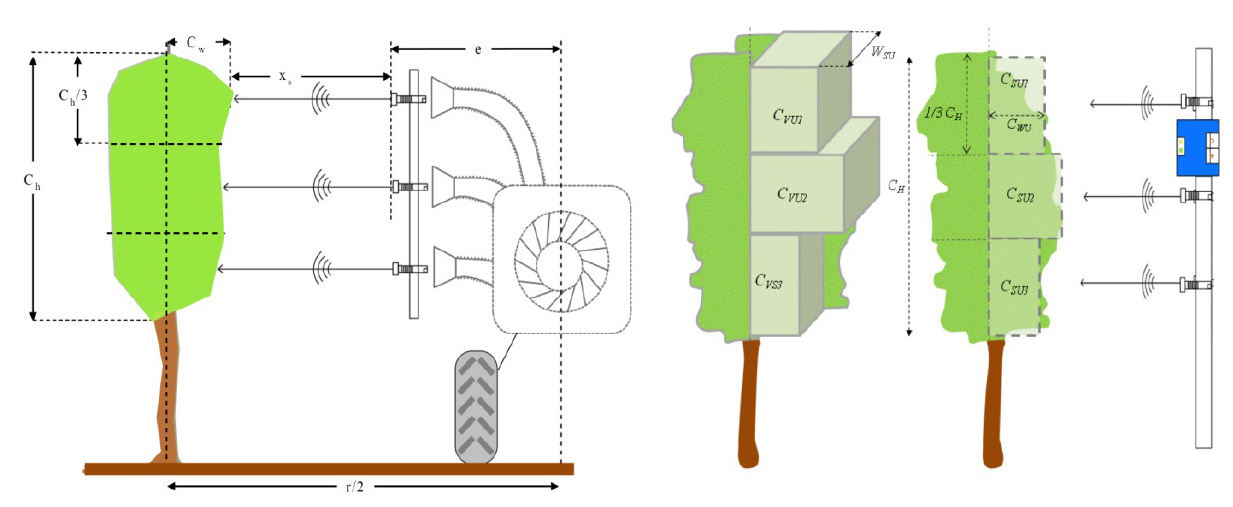
Figure 3. Functioning principle of ultrasonic sensors. Distance to the external layout of the crop (left) can be transformed into crop volume